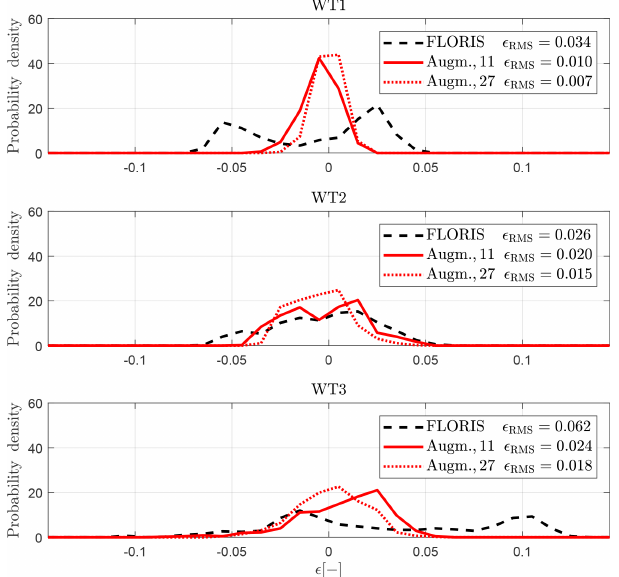
Figure 10. Error distributions for each turbine for all tested con- figurations, for the baseline FLORIS model (black dashed line), the 11-parameter augmented model (red solid line), and the 27- parameter augmented model (red dotted